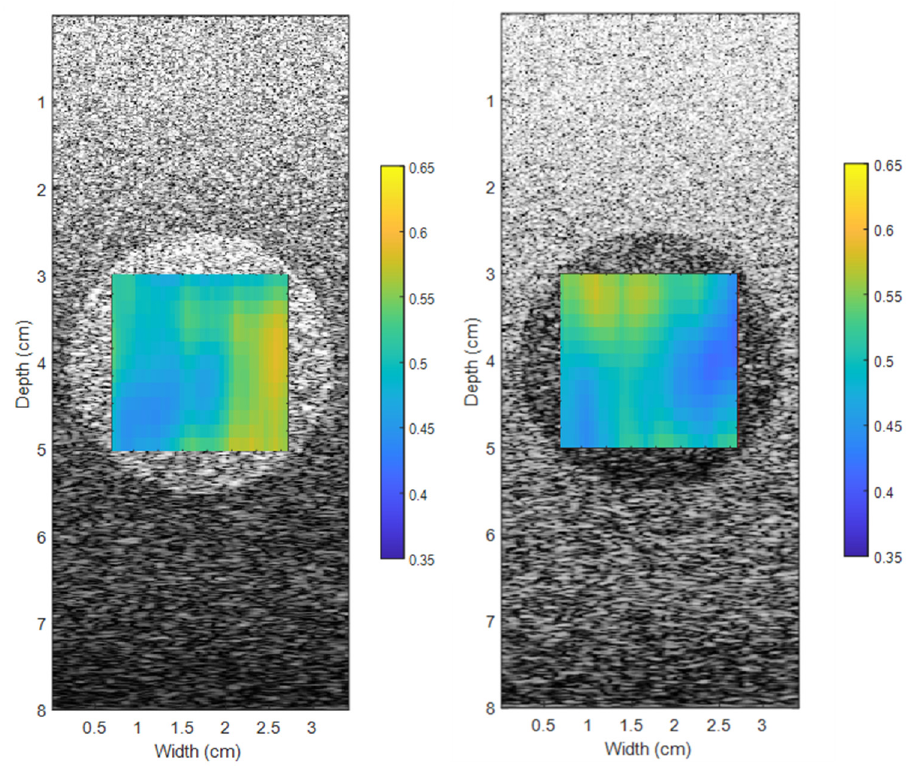
Figure 9. Representative Q-mode image combining B-mode image of TM phantoms with an attenuation map.